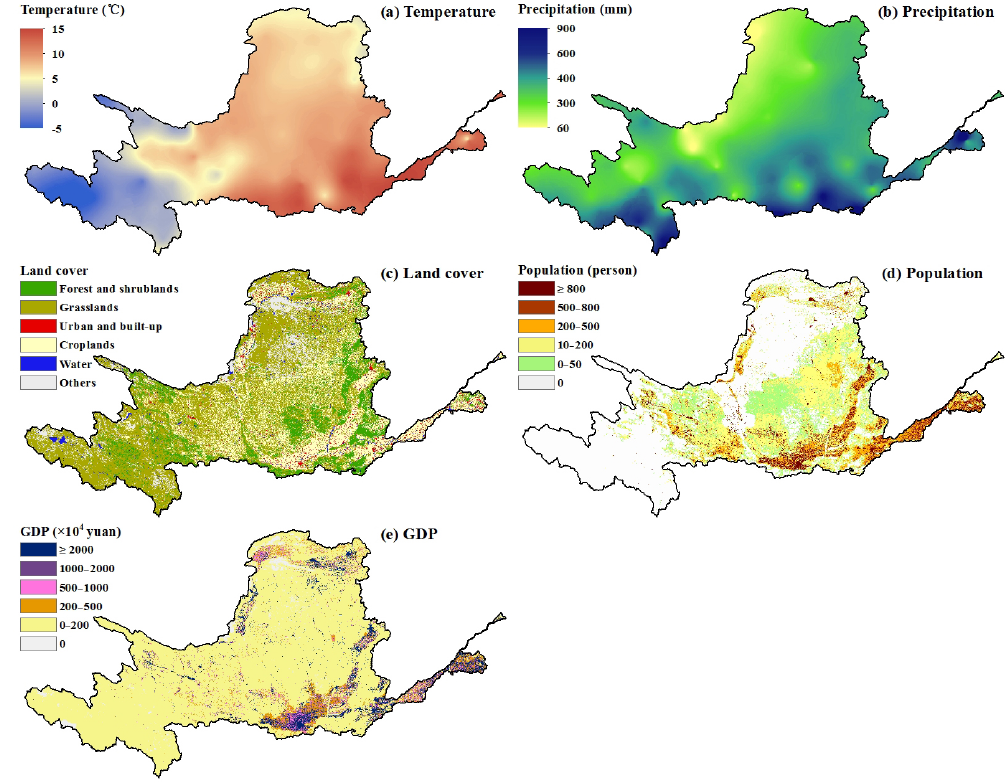
Figure 2. (a) Mean temperature (1981–2010), (b) annual mean precipitation (1981–2010), (c) land cover in 2010, (d) population in 2010, and (e) gross domestic product (GDP) in 2010 in the YR basin.